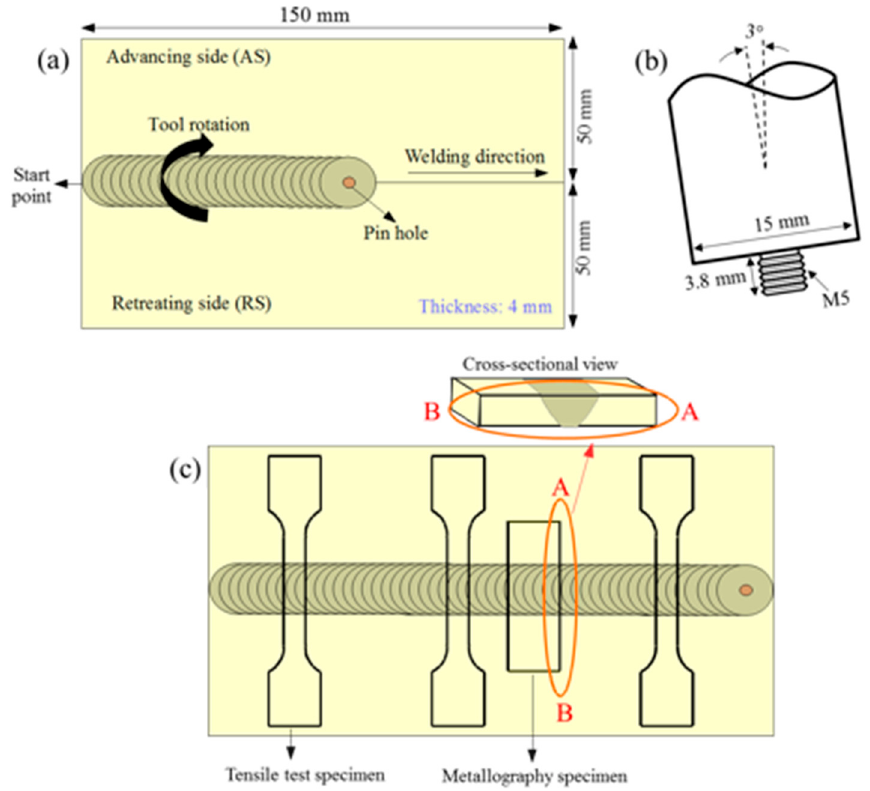
Figure 1. Schematic of the friction stir welding (FSW) process: ( a ) butt joint configuration, ( b ) FSW tool, and ( c ) location of the machined specimens.